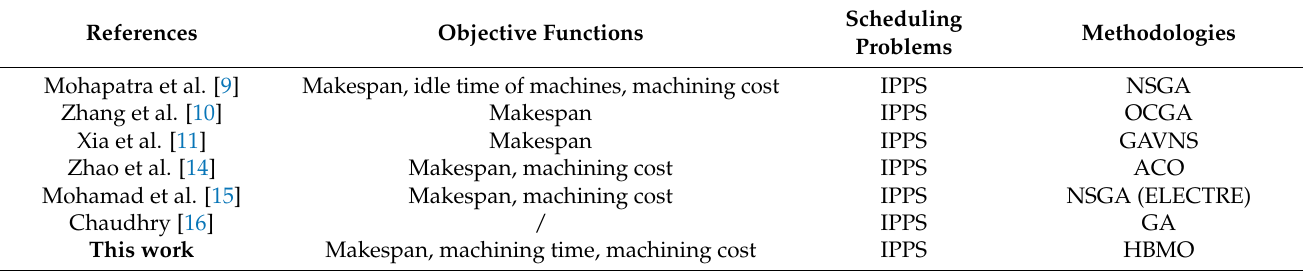
Table 1. Literature